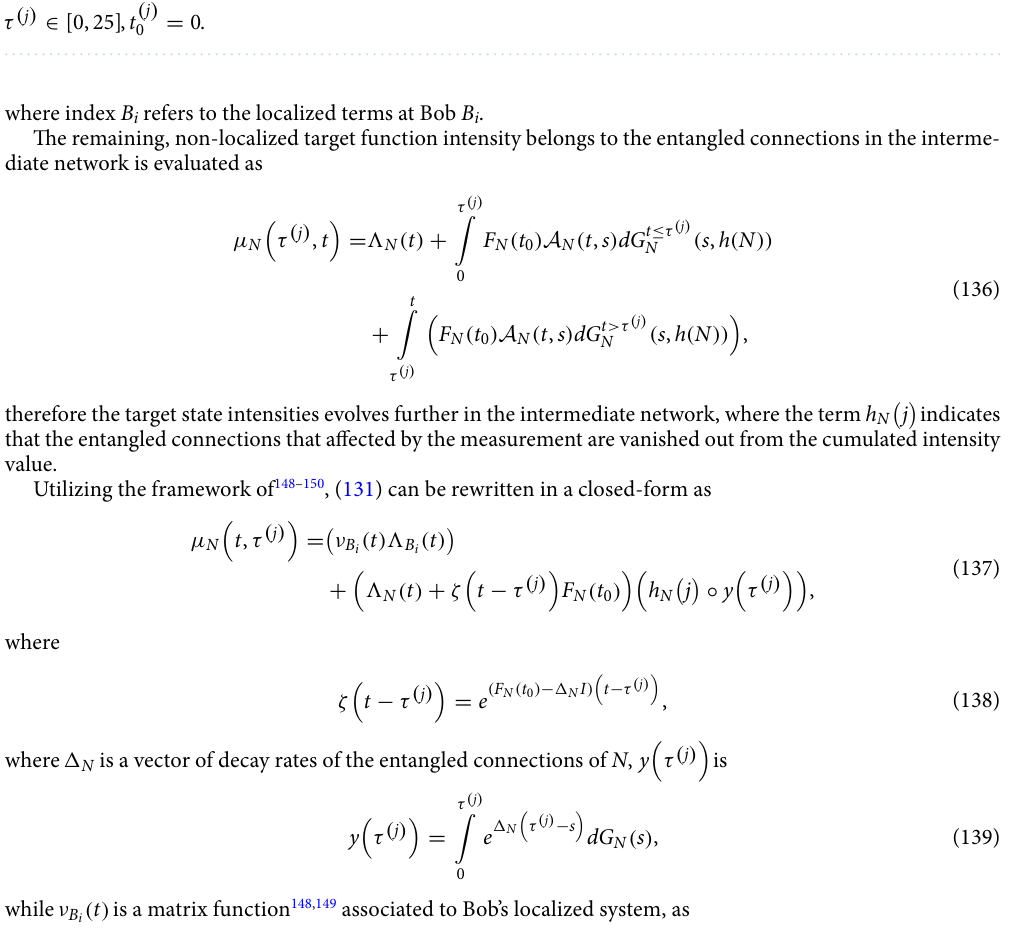
Figure 6. Scaling of the A j